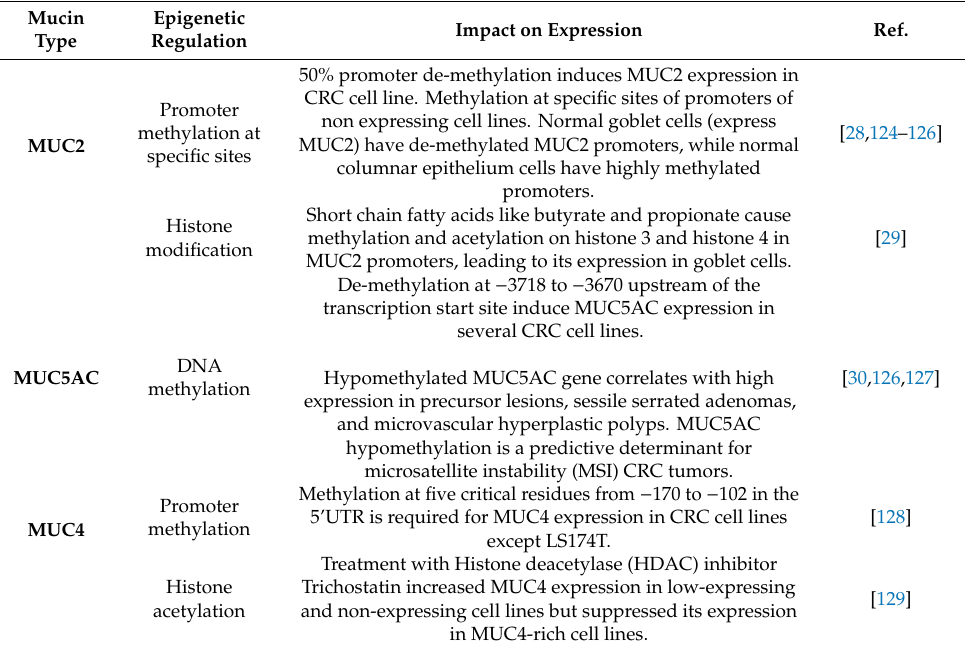
Table 1. Epigenetic regulation of secreted and transmembrane mucins of colon.